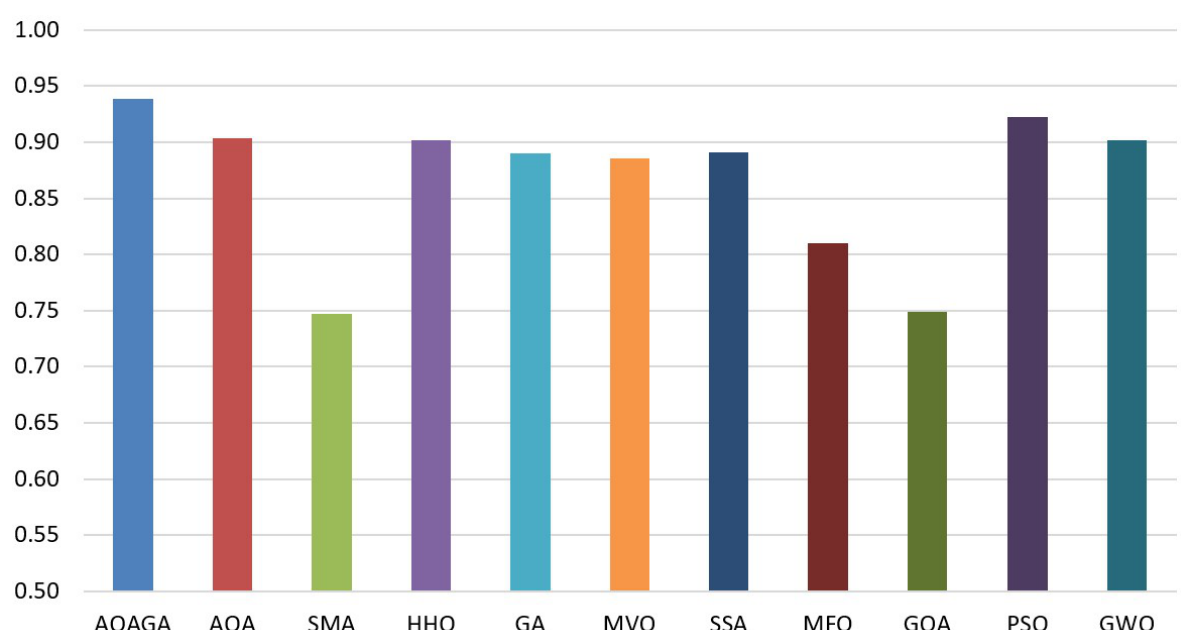
Figure 4. Average of the accuracy measure values for all